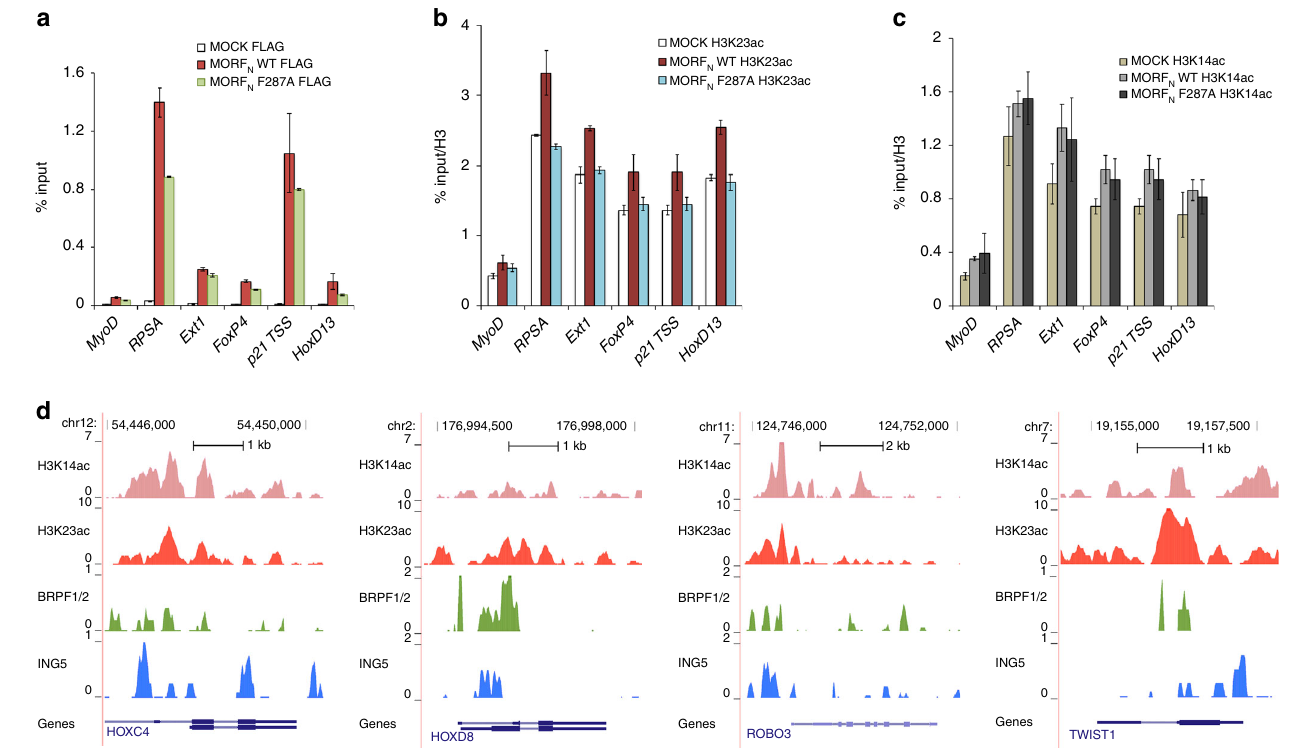
Fig. 6 MORF DPF role in MORF localization in vivo and deposition of H3K23ac. a ChIP analysis of wild-type FLAG-MORF N and mutant FLAG-MORF N F287A in transfected 293T cells. b , c ChIP analysis of H3K23ac ( b ) and H3K14ac ( c ) in the same transfected cells as in a . Acetylation levels were corrected for nucleosomes occupancy (total H3 signal). All ChIP values are based on two independent experiments and error bars indicate the range between the samples. d ChIP-seq pro fi les of the MORF complex subunits (BRPF1/2 detected with the Brd1 Ab and ING5) in human RKO cells and of histone modi fi cations (H3K14ac and H3K27ac) in HMEL cells are shown. The bottom tracks correspond to the representative RefSeq